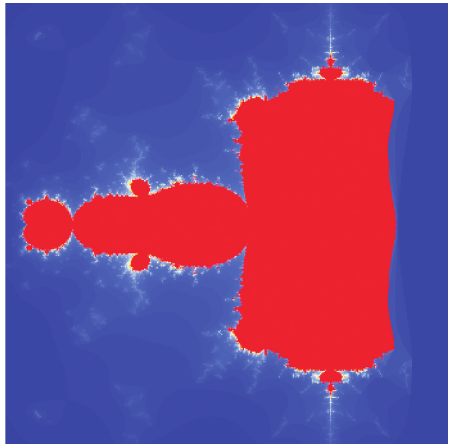
Figure 14: Quadratic Mandelbrot set in JSOmhh.